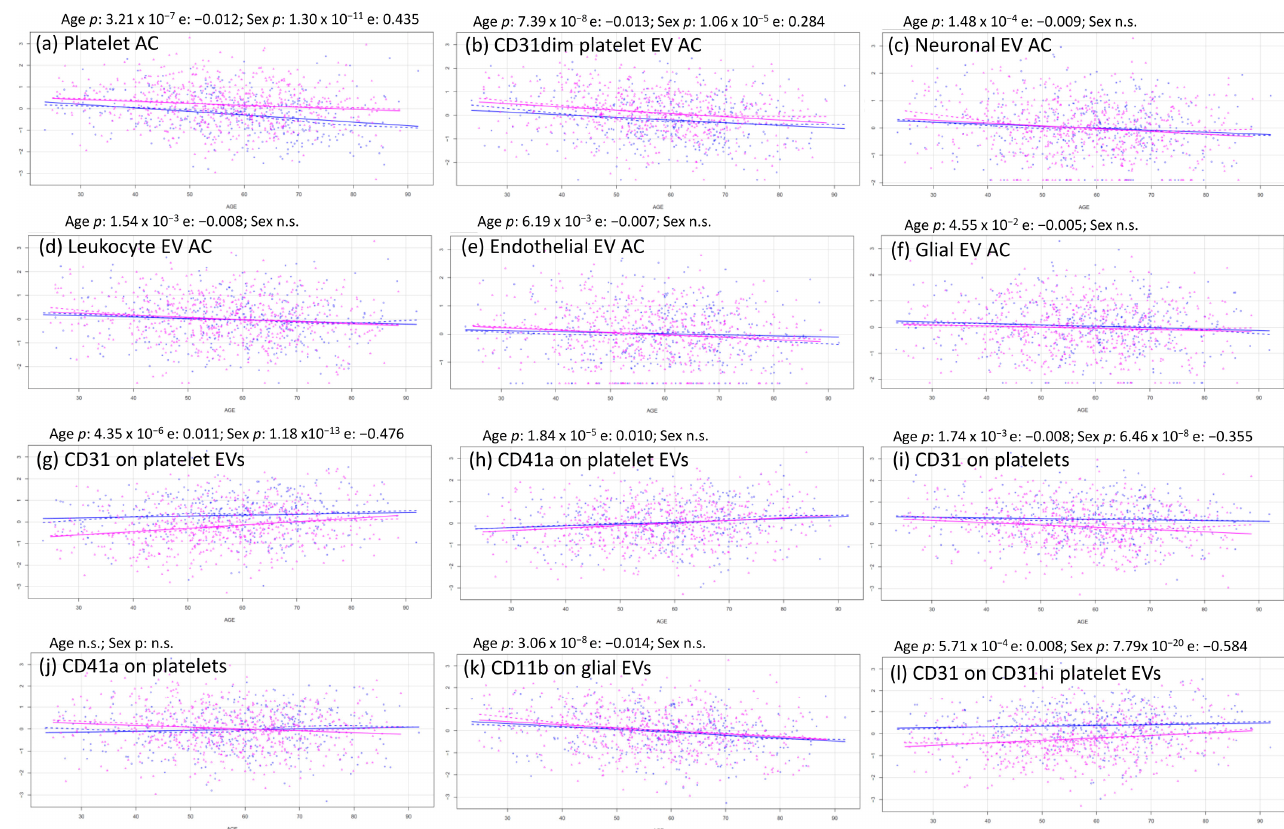
Figure 2. Most relevant age–sex tendencies of EVs and platelets. Each scatter plot represented males in blue and females in pink, age in the x axis, and normalized trait in the y axis.